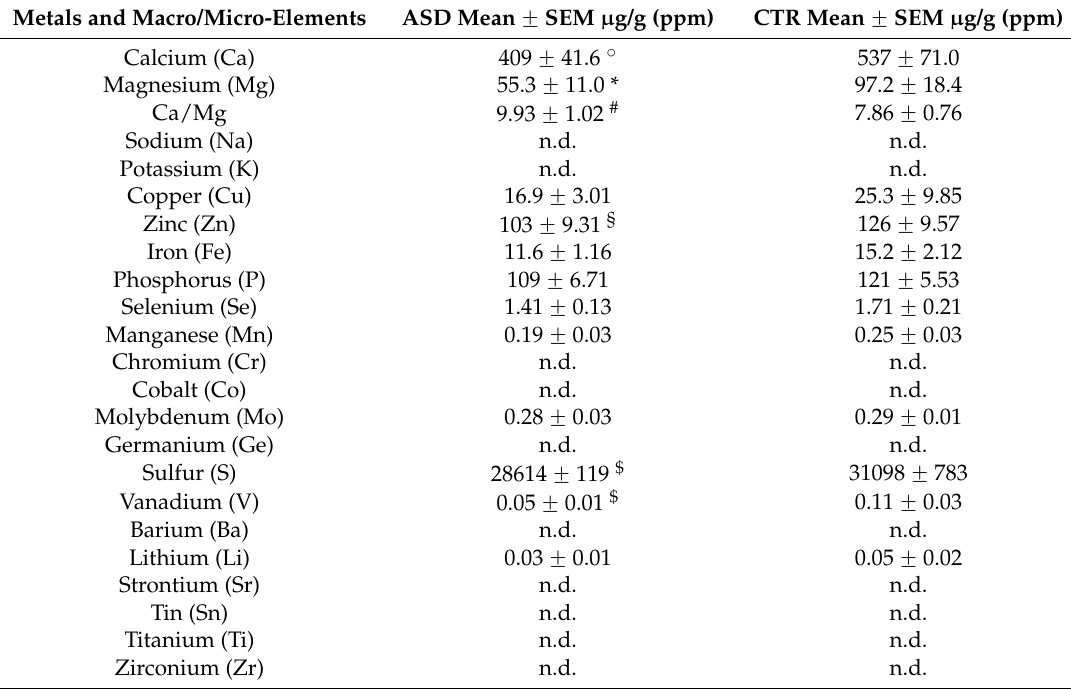
Table 1. Metals and macro/microelements in hair of ASD and CTR children.